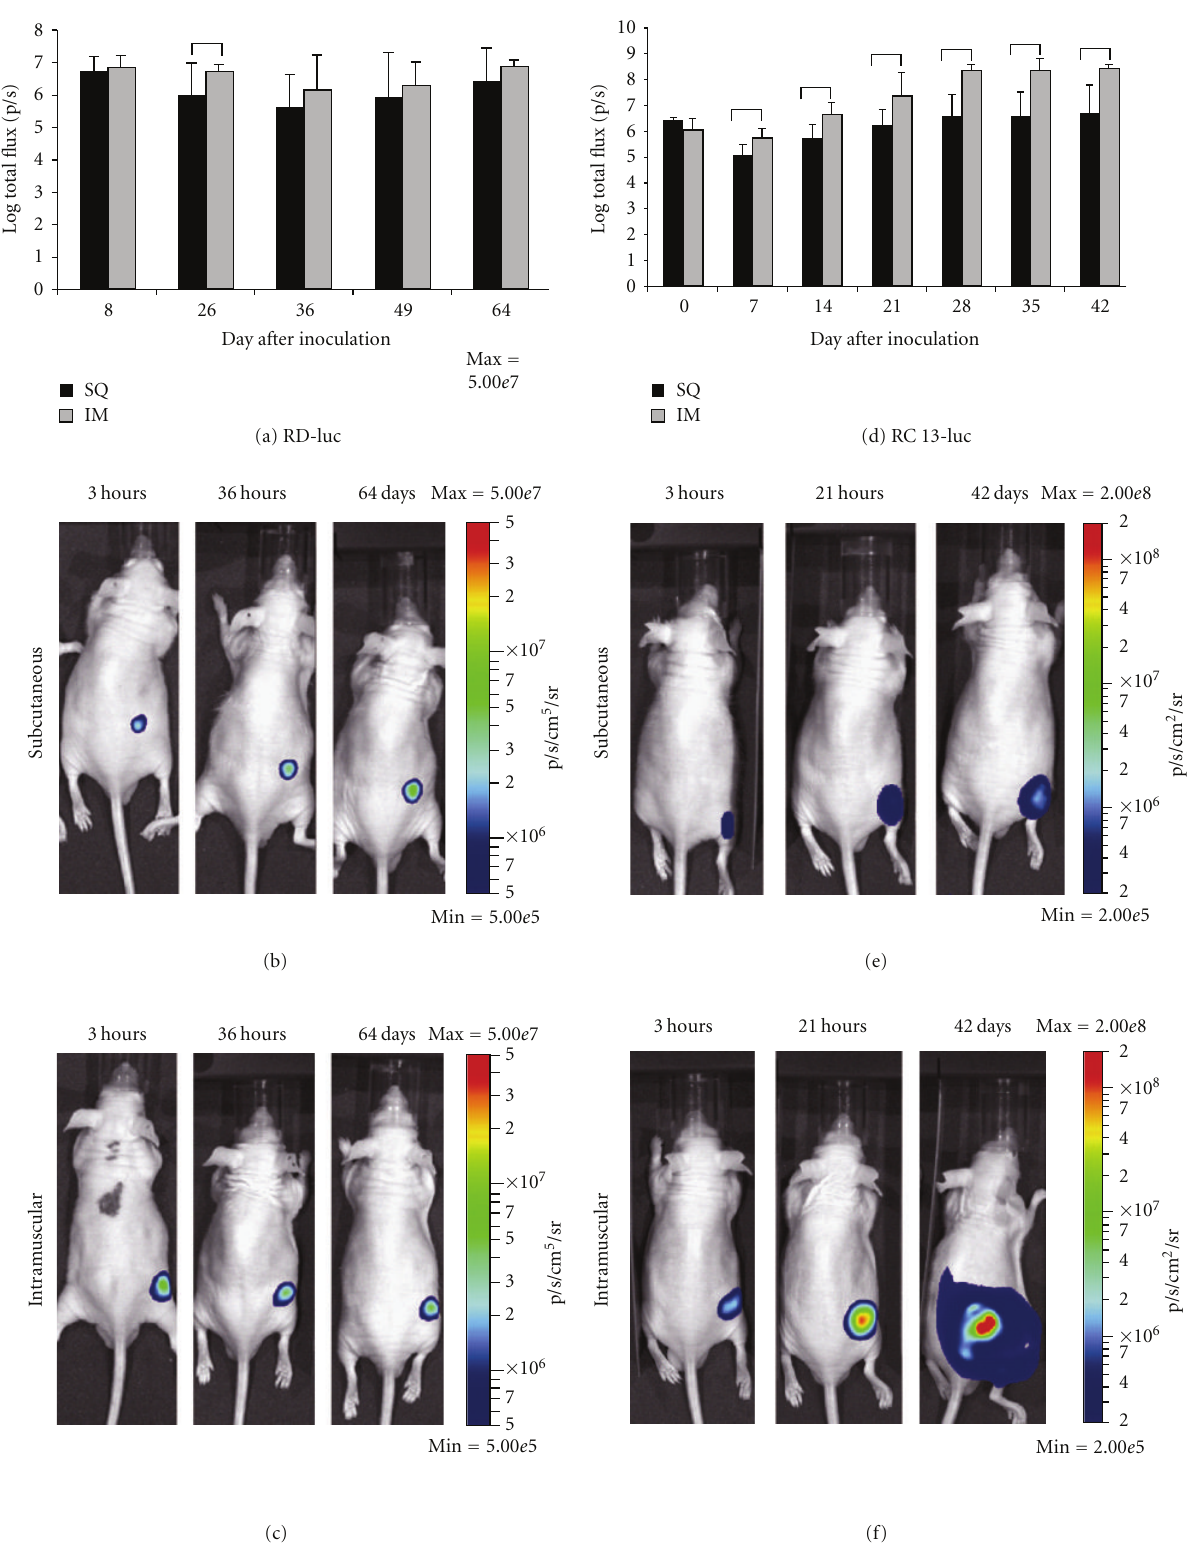
Figure 3: Serial bioluminescence imaging demonstrating successful tumor engraftment resulting from subcutaneous and intramuscular inoculation of RD-luc and RC13-luc tumor cells. (a) The growth of RD-luc tumors did not demonstrate substantial tumor growth when implanted either (b) subcutaneously or (c) intramuscularly. (d) Modest growth of RC13-luc cells were implanted (e) subcutaneously, whereas aggressive tumor growth resulted when this cell line was inoculated intramuscularly. Bar graphs show log-photon flux ± 1SD; brackets indicate P ≤ . 05 by Student’s t